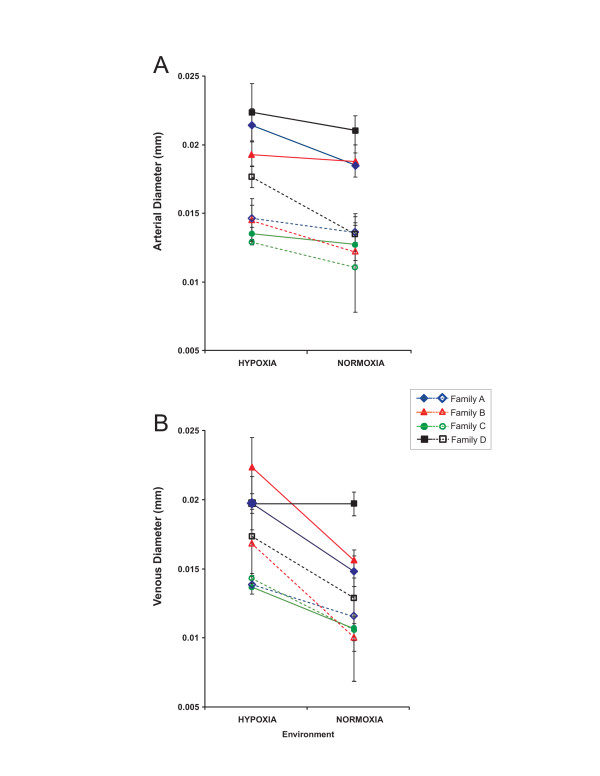
Mean vessel diameter by family and environment. A) Family mean arterial diameter in mm for larvae reared in normoxic and hypoxic environments. Solid lines and symbols represent means for dorsal aorta. Intermittent lines and open symbols represent means for caudal arteries. B) Venous diameter in mm for larvae reared in each environment. Solid line and symbols represent means for dorsal vein. Intermittent lines and open symbols represent veins. Error bars represent one standard error. Significant variation exists between families for venous diameter, while significant variation between environments in arterial diameter.